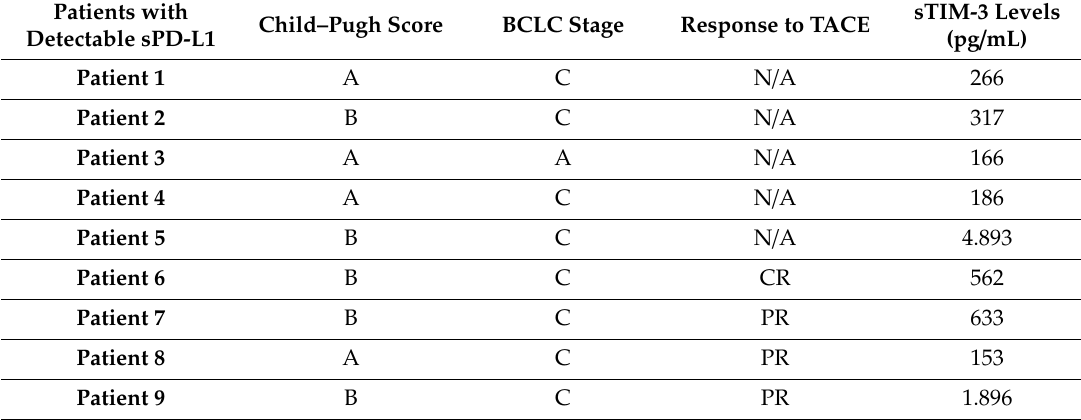
Serum TIM-3 values and clinical characteristics in patients with detectable serum PD-L1. Univariate logistic regression was applied for the association of sTIM-3 values with the probability of sPD-L1 detection. sTIM-3; serum T-cell immunoglobulin and mucin domain-3, sPD-L1; serum programmed death ligand-1, BCLC; Barcelona Clinic Liver Cancer, TACE; transarterial chemoembolization, CR; complete response, PR; partial response, N / A; not applicable for the patients who were not submitted to